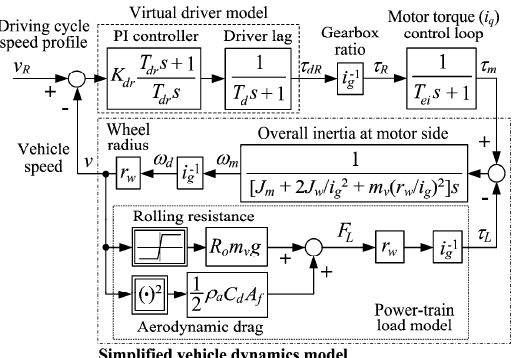
Figure 7. Vehicle dynamics model comprising equivalent vehicle inertia, rolling resistance and air drag effect referred to the motor side, controlled by a PI controller-based virtual driver. Table 1. Parameters of DC bus control system simulation model.